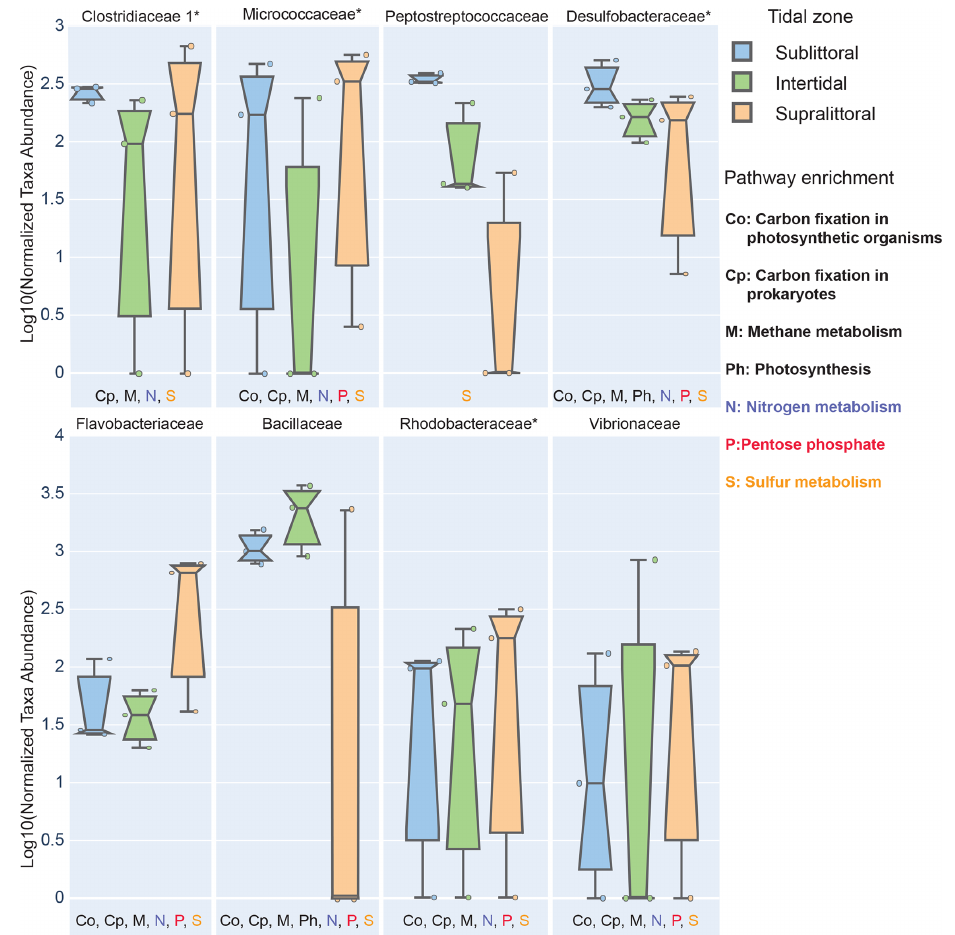
Figure 4. Zone-specific measures of taxa showing significant enrichment in sediments of different tidal zones. Here we show prokaryotic families that have significantly different abundances between zones and whose mean effect size exceeded 10% in at least one zone. To be labeled with a metabolic pathway, taxa were required to have at least 10% of three KOs in that pathway in any zone. Families with a median NSTI within 1SD of 0.15 are labeled with